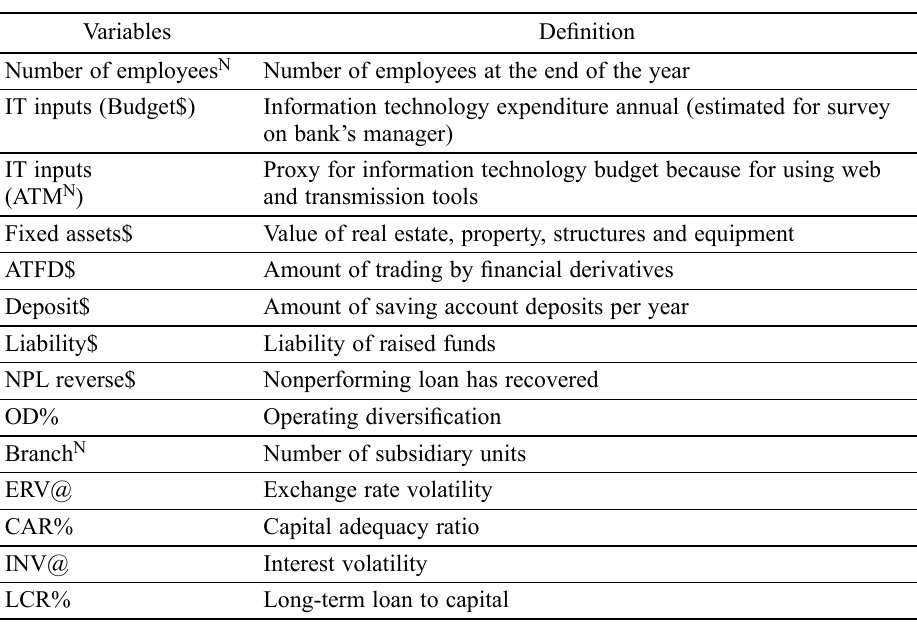
Table 1. Definitions and source of